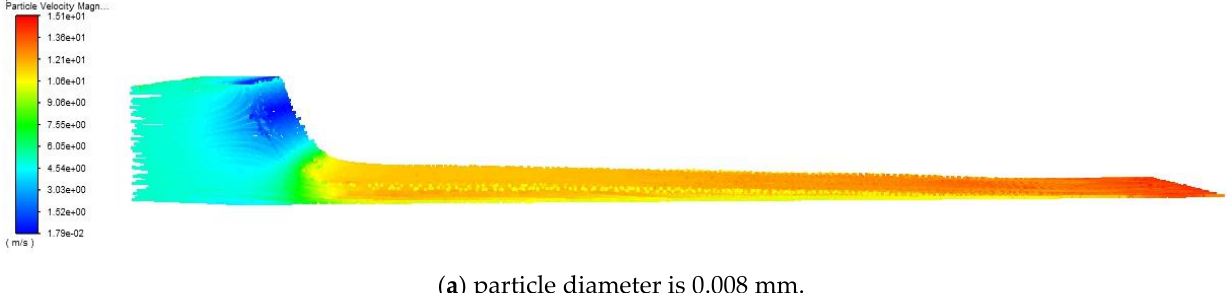
Figure 9. Cloud diagram of particle velocity distribution under different particle sizes.